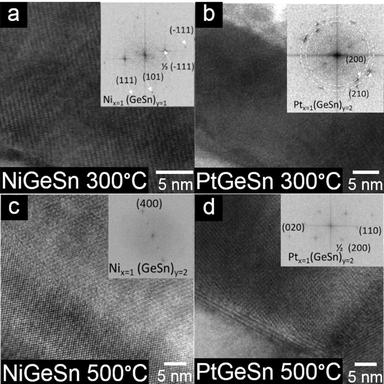
Lattice resolution TEM images of NiGeSn sample formed at 300 °C (a) and 500 °C (c), depicting individual crystal grain and of PtGeSn sample formed at 300 °C (b) and 500 °C (d) featuring small crystallites with random orientations. Insets are corresponding FFTs.